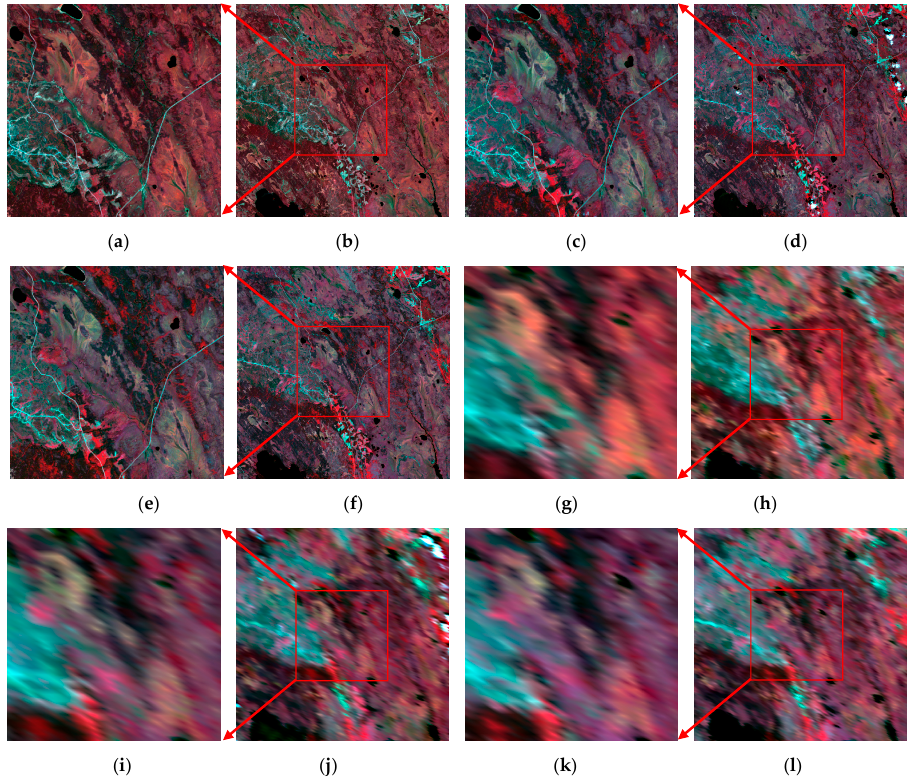
Figure 2. Employed Landsat and MODIS reflectance data (NIR/red/green) of the rural dataset: ( a ‒ f ) Landsat ETM+ images with a size of 500 × 500 and 2000 × 2000 pixels on 24 May, 11 July, and 12 August 2001, respectively; ( g ‒ l ) MODIS images correspond to ( a ‒ f ).